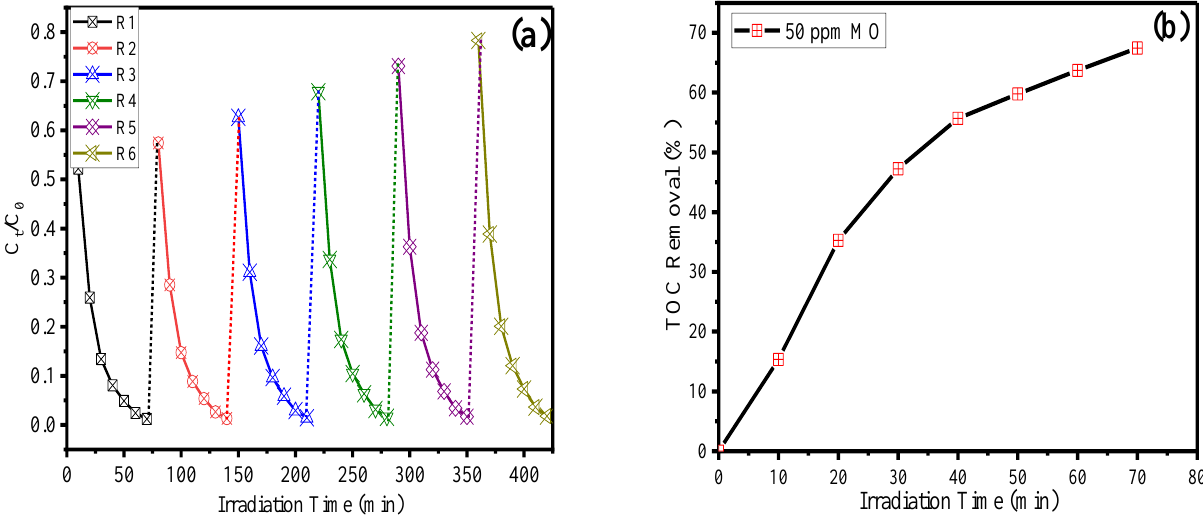
Figure 11. ( a ) Reusability and stability test for the synthesized Ni 1 − x Mn x WO 4 NC. ( b ) TOC analysis during degradation of MO.